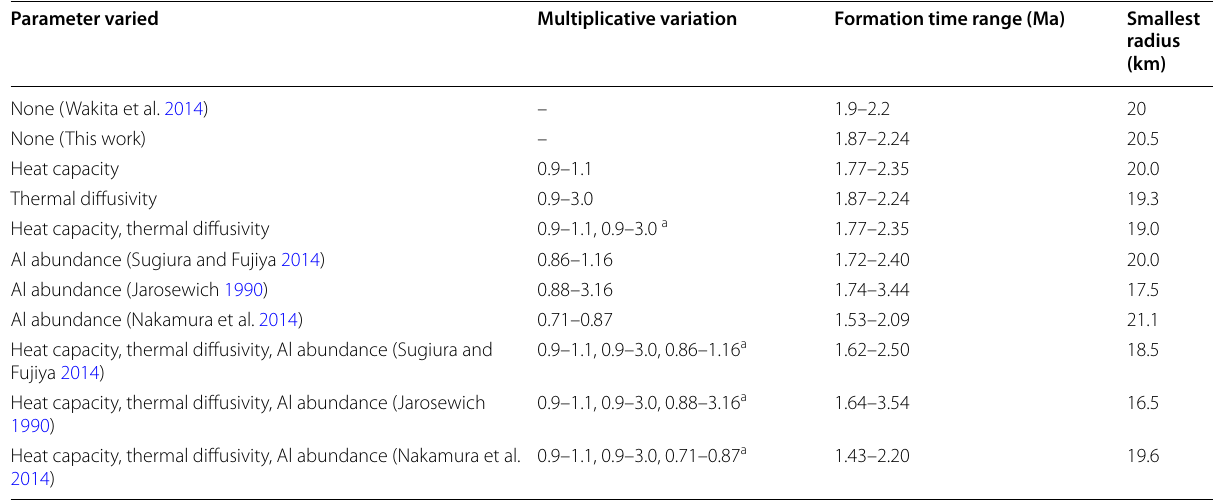
a These comma-separated values correspond to the respective parameters in the first column